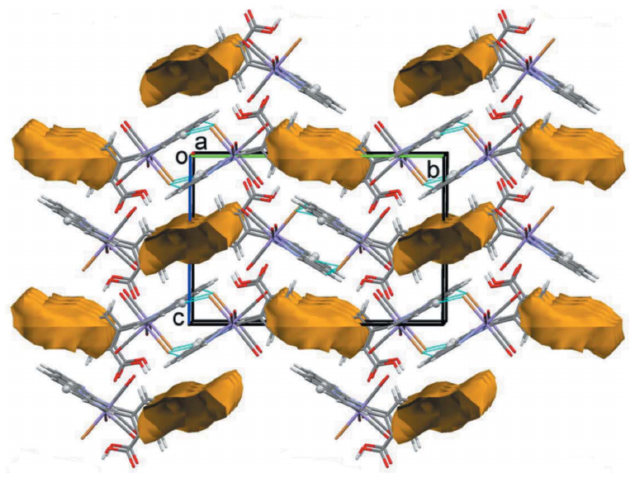
Figure 5 A view along the a axis of the crystal packing of compound I . The C— H (cid:2)(cid:2)(cid:2) Br hydrogen bonds (Table 1) are shown as dashed lines and the regions occupied by the disordered THF solvent molecules as yellow/ brown cavities ( Mercury ; Macrae et al. , 2008). Only the major component of the disordered benzoic acid group is shown.